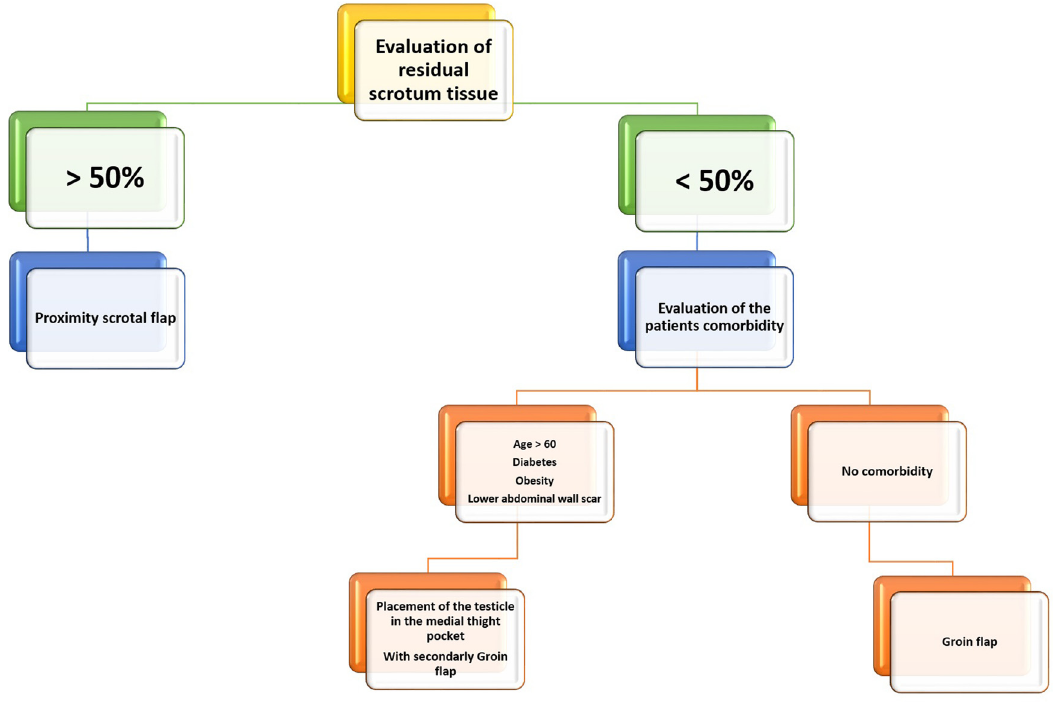
Figure 6: Algorithm of approach to scrotal region reconstruction